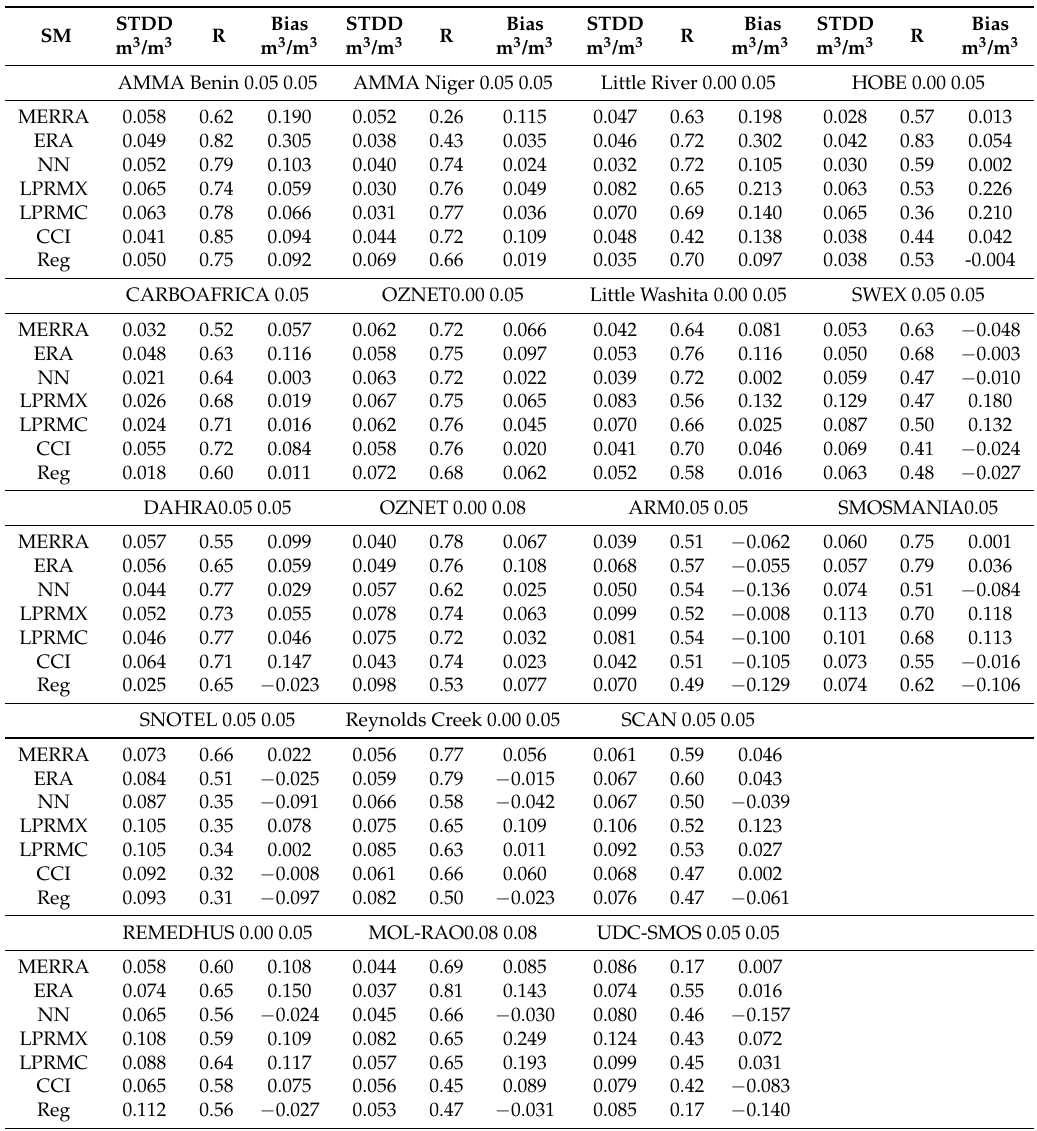
Table 4. Standard deviation of the difference (STDD), Pearson correlation and bias computed for the respect to in situ measurements. The bias is defined as the mean of a given SM product minus the mean of in situ